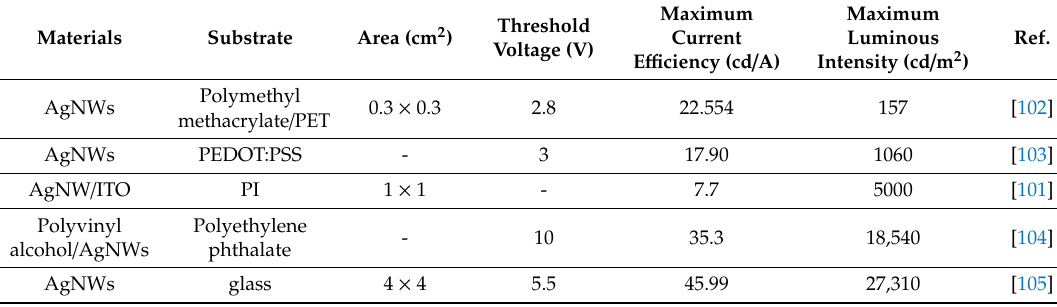
Table 5. Performance of AgNW-based optoelectronic